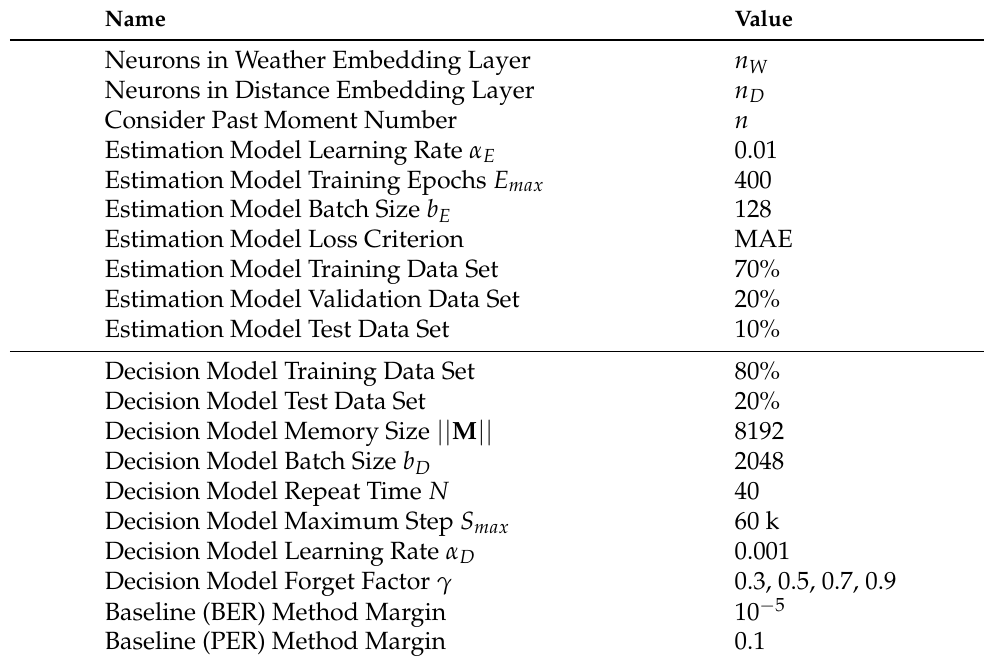
Table 3. Parameters in estimation model and decision